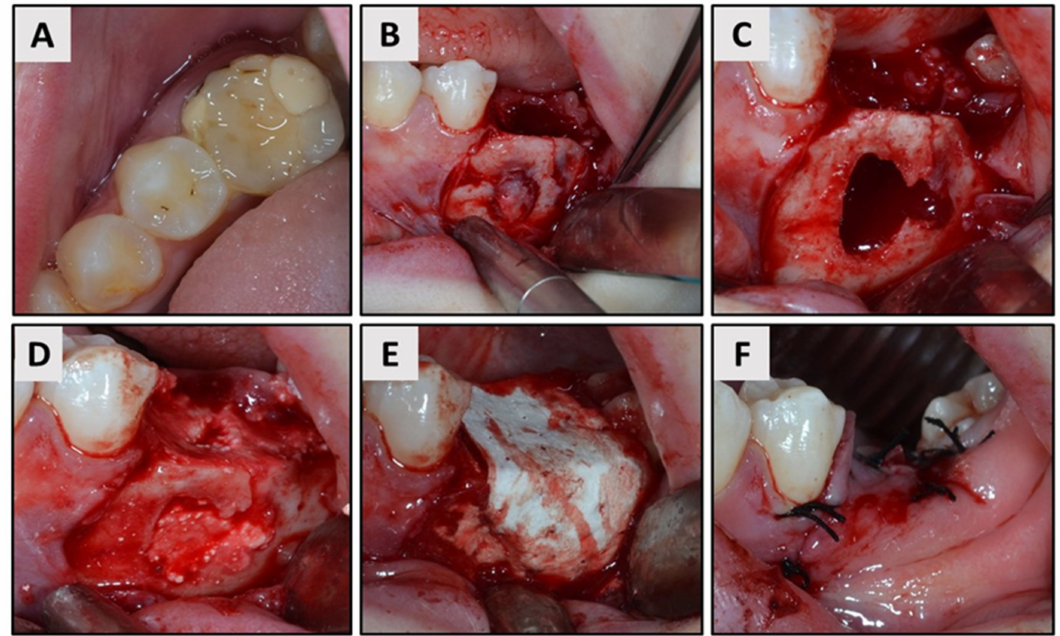
Figure 2. ( A ) Occlusal aspect of hopeless tooth #19. ( B , C ) Exposure of buccal fenestration after flap elevation and curettage of the infected tissue. ( D ) Application of injectable synthetic bone graft (ISBG) into the extraction socket. ( E , F ) Coverage of the defect with resorbable membrane and final wound